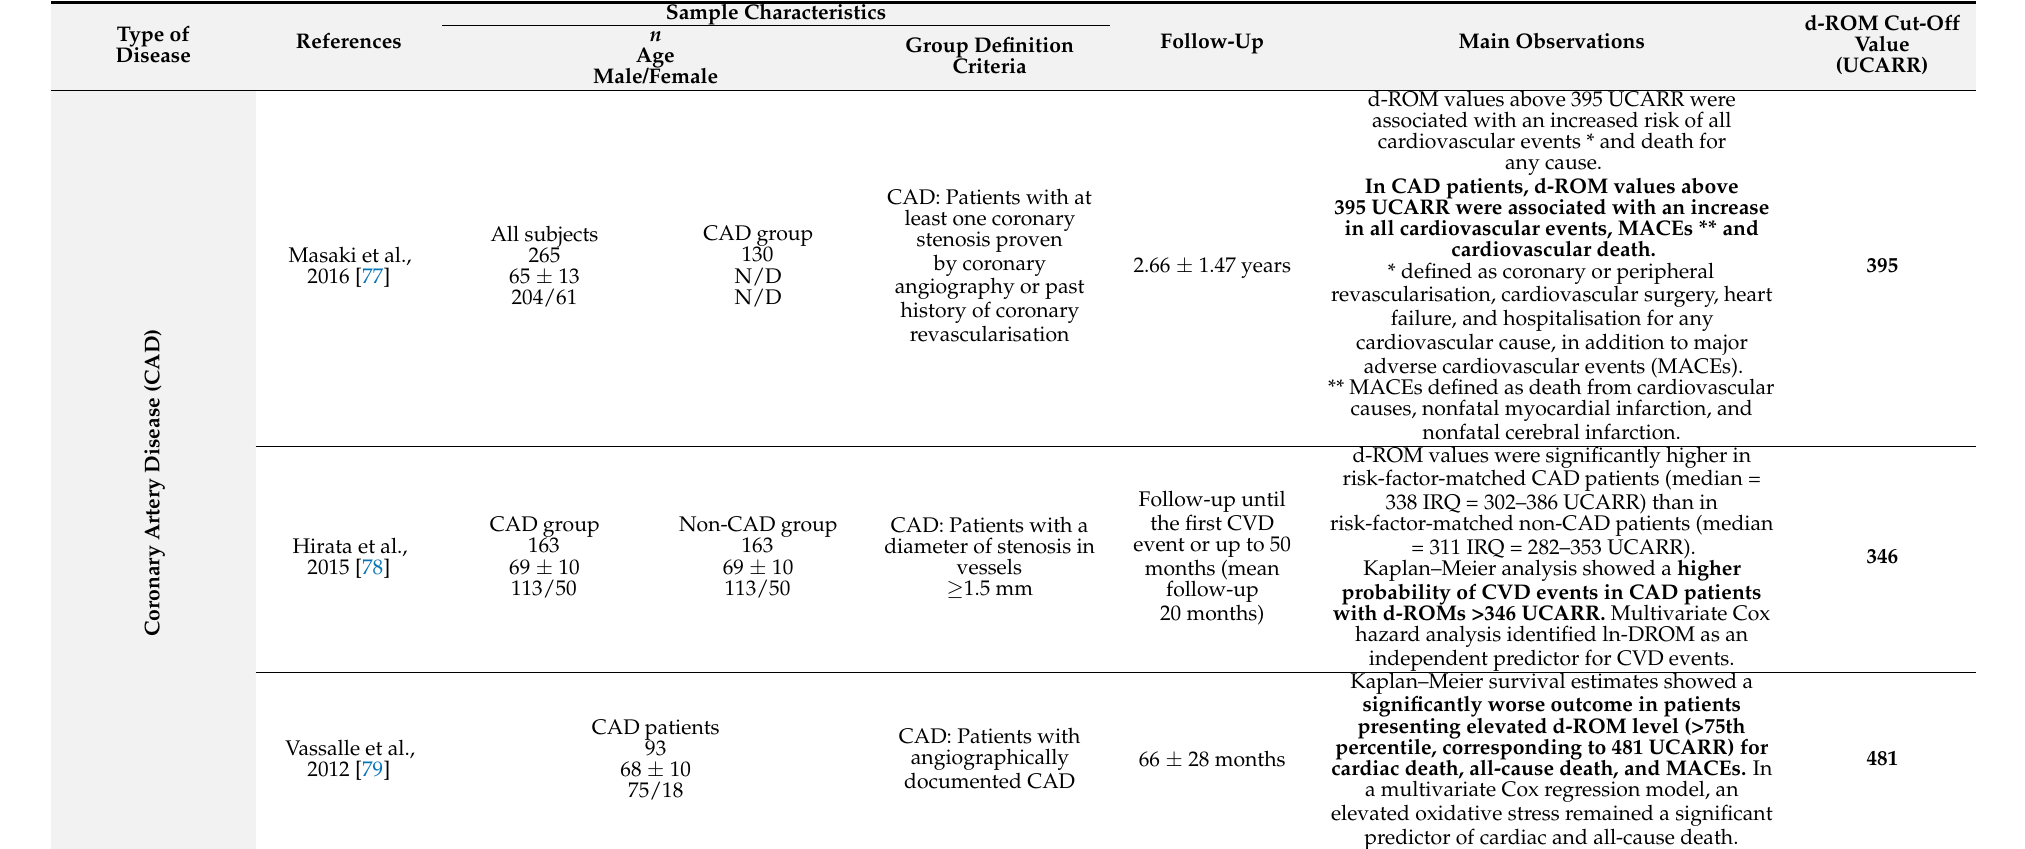
Table 1. List of studies evaluating d-ROM values and the occurrence of CVD events and mortality in individuals with known